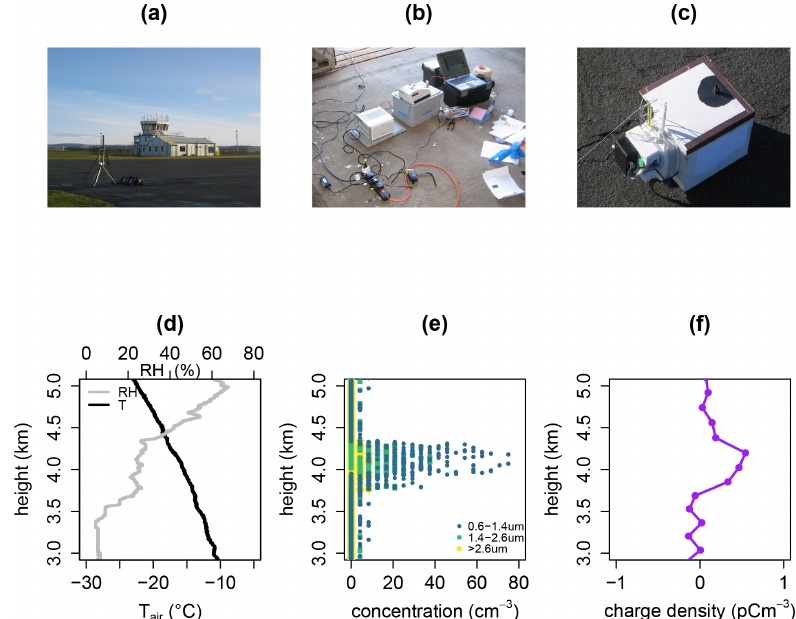
Figure 13. Research radiosondes used in an emergency to locate the 2010 Eyjafjallajökull volcanic plume over the UK. (a,b) Temporary receiving station at RAF West Freugh near Stranraer, Scotland, under clear skies, for launch of an enhanced sonde able to measure particle size distribution. (d) Part of the meteorological sounding following launch at 08:30UTC on 19 April 2010. (e) Profile of plume concentrations for micrometre diameter particles and (f) simultaneous measurement of charge density within the plume region. (Adapted from Harrison et al., 2010.)